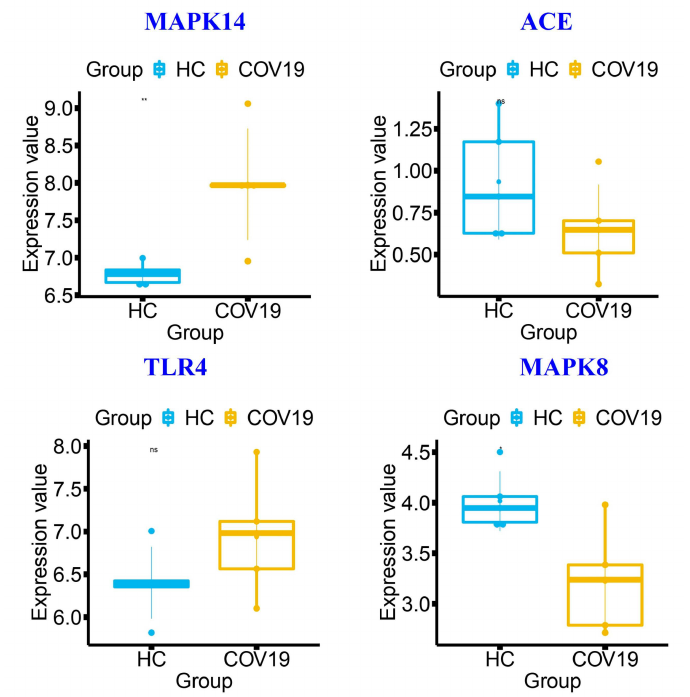
Figure 9. Box plots encode the 4 COVID-19-associated gene expression levels in COVID-19-infected compared with healthy controls (HCs). The plots indicate that the players were dysregulated after the SARS-CoV-2 infection. HCs are marked in blue, and COVID-19-infected tissues are marked in yellow. Significant difference of the expression value was calculated by inbuilt ANOVA and significant **: p ≤ 0.01; ns: p ≥ 0.05; *: p ≤ 0.05